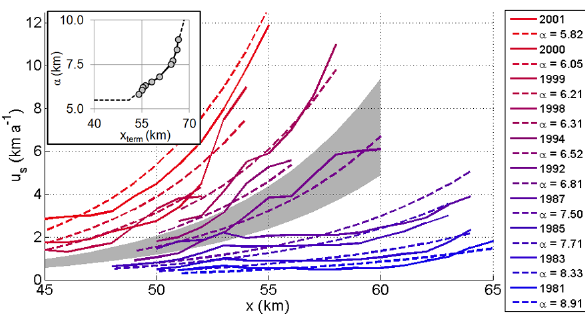
Fig. 3. Observed ice surface velocity ( u s ) profiles at Columbia Glacier over the 1981 to 2001 period (solid lines; Pfeffer, 2007) and their corresponding parameterizations (dashed lines; Eq. 5) us- ing differing values of exponential length scale ( α) . Grey shading denotes α ± 0 . 25km around the 1992 profile. Inset: The empirical relation between exponential sliding length scale ( α) and terminus position ( x term ) used in this